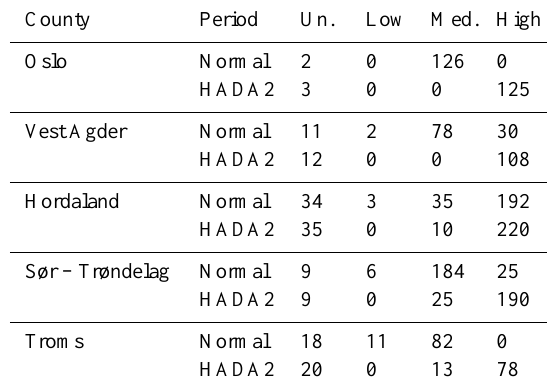
Table 1. Number, in thousands, of buildings in wood decay risk zones for selected counties in Norway. Upper number is the normal climate (1961–1990), and lower number is projected climate (2071– 2100). Period Un.